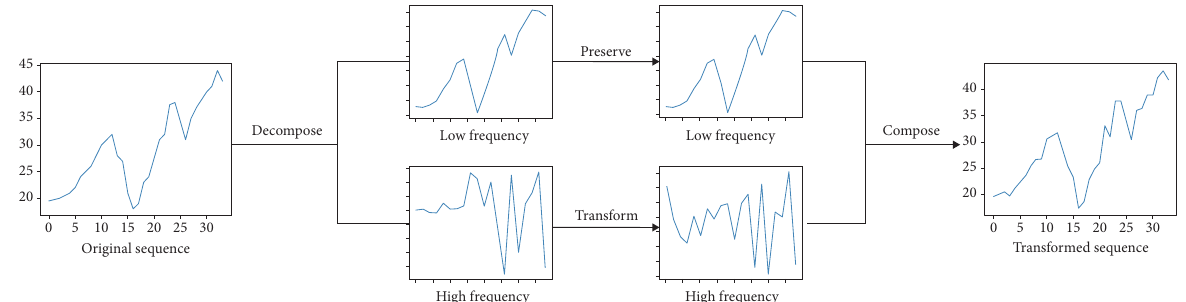
Figure 2: The overview of the proposed data augmentation